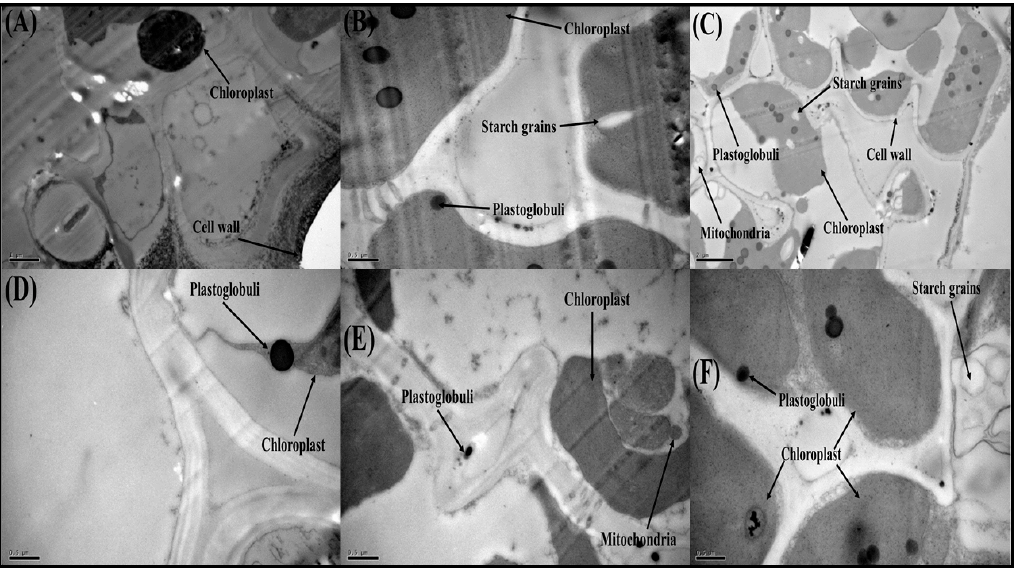
Figure 8. Transmission electron microscopy (TEM) analysis of Oryza sativa (cultivars) leaf structure after treated with Cd and Fe concentration in the nutrient solution. ( A ) Shan 63 (5,000) with Cd 100 + Fe 0, ( B ) Shan 63 (2500) with Cd 100 + Fe 50, ( C ) Shan 63 (10,000) with Cd 100 + Fe 100, ( D ) Lu 9803 (2500) Cd 100 + Fe 0, ( E ) Lu 9803 (2500) Cd 100 + Fe 50 and ( F ) Lu 9803 (2500) Cd 100 + Fe 100.